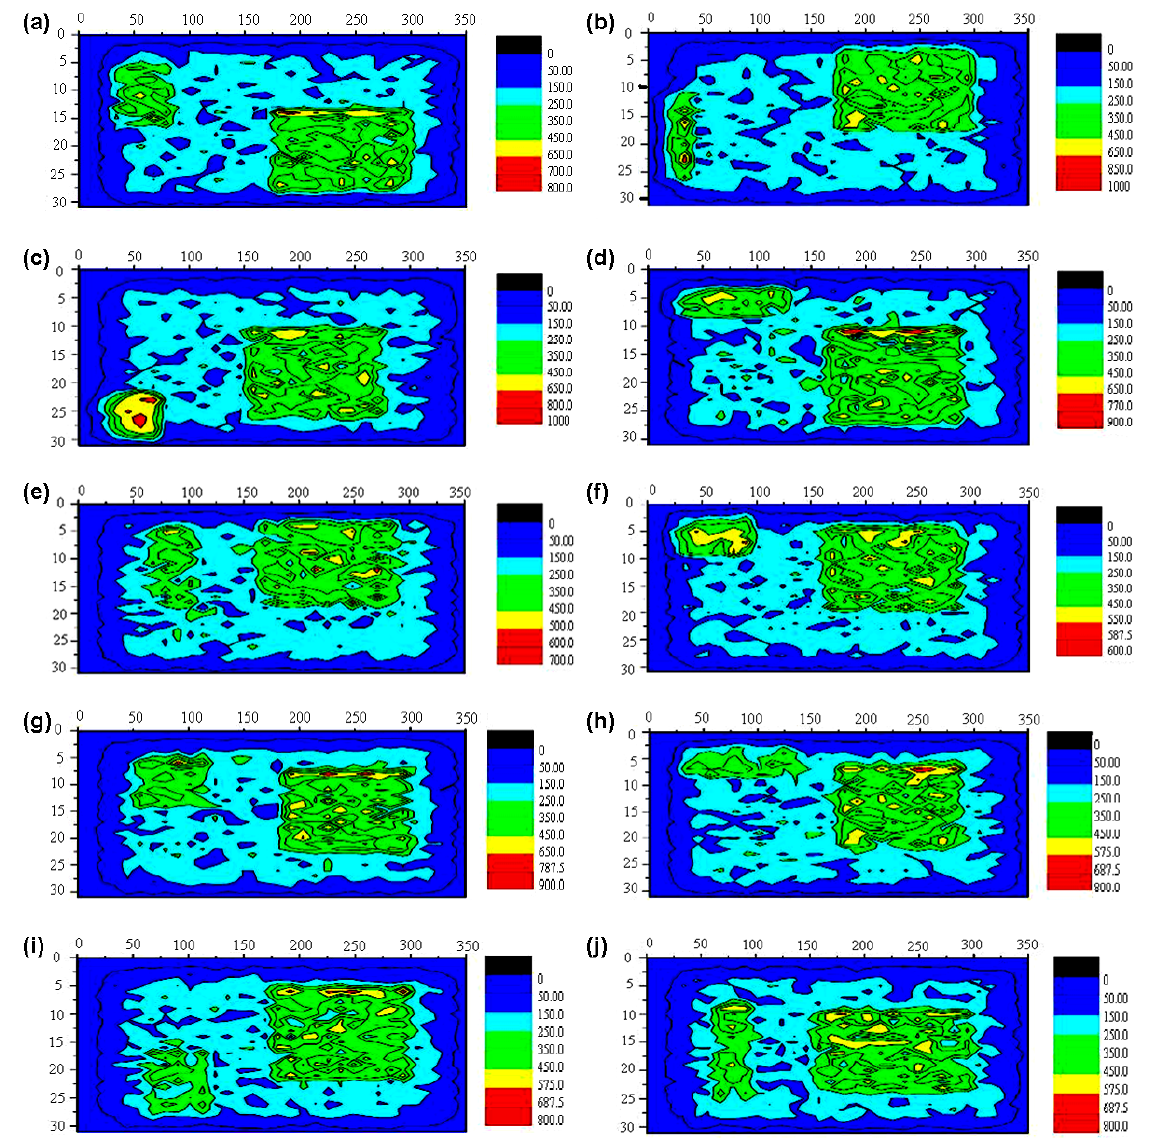
Figure 8. Ten hybrid source models in the case of Wenchuan Earthquake, redrawn from Liu and Tao